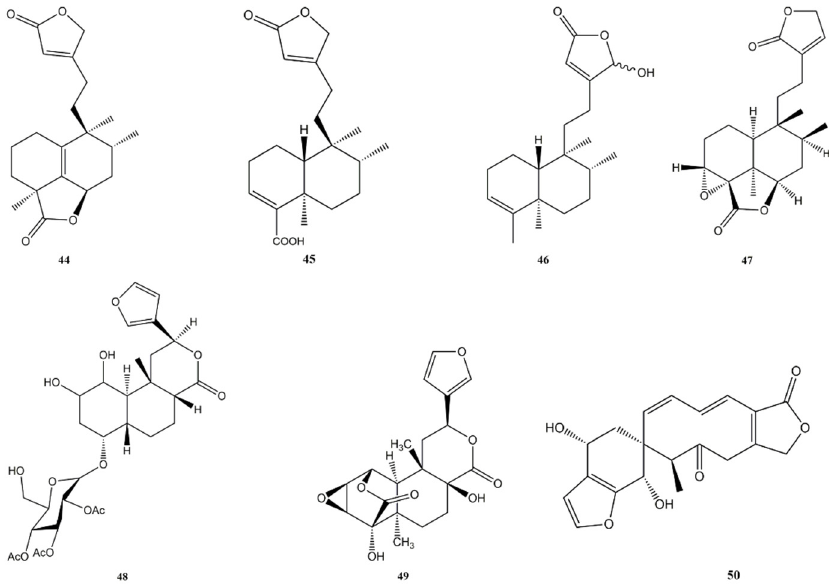
Figure 9. Bioactive clerodane diterpenes: Crassifolin U ( 44 ); Clerodermic acid ( 45 ); 16-Hydroxycler- Teotihuacanin ( 50 oda-3,13-dien-15,16-olide ( 46 ); Crispene E ( 47 ); TC-2 ( 48 ); 8-Hydroxytinosporide ( 49 ); Teotihuacanin ( 50 ).